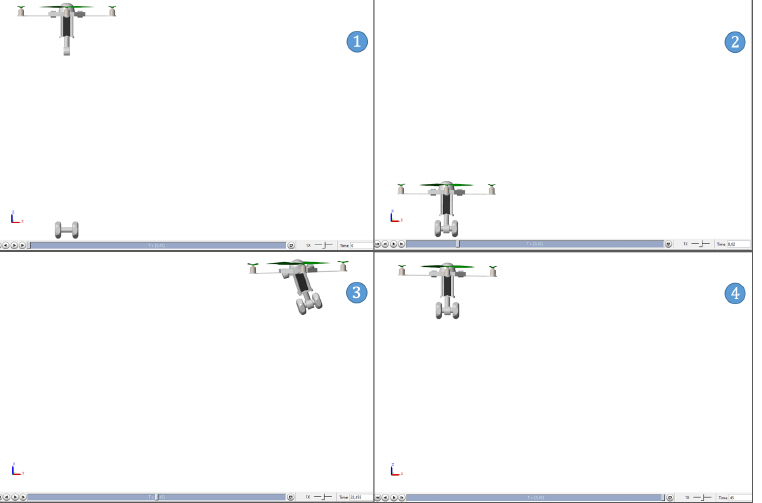
Figure 6. Second case study: screenshots of Matlab’s Mechanics Explore. ( 1 ) ODQuad stays in hovering position. ( 2 ) ODQuad grasps the object, ( 3 ) ODQuad performs a position and orientation trajectory. ( 4 ) ODQuad comes to the initial configuration moving the grasped object. The position tracking error, reported in Figure 7a, increases along the z axis during the grasping phase (at about 10 s), as expected, and comes back to the initial value after 3 s. In other words, after an initial transition due to the first contact with the object, the wrench estimator allows to correctly compensate the effect of the additional load attached to the vehicle.